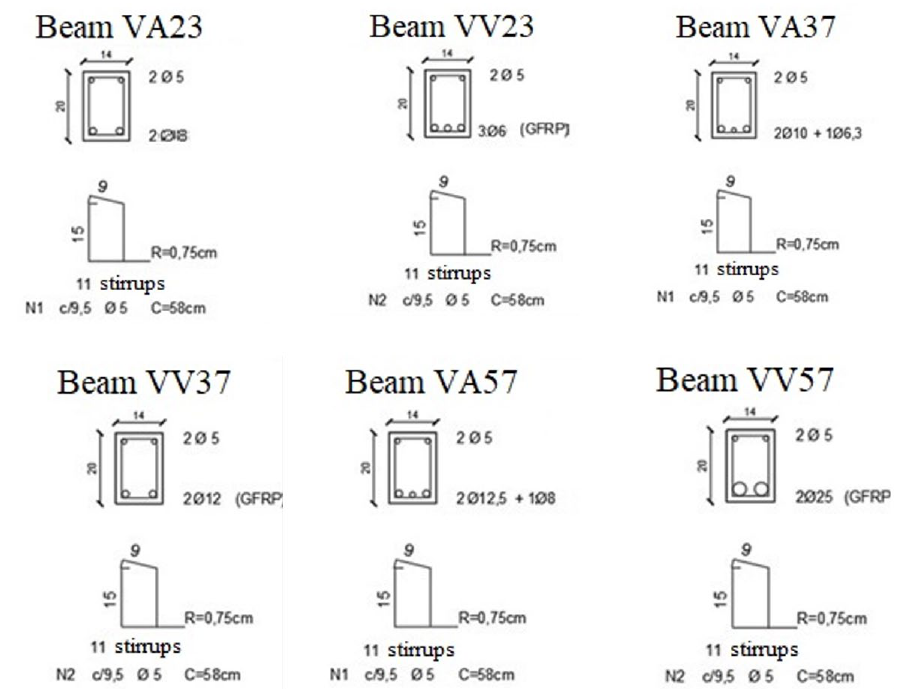
Figure 3. Transversal detailing of the tested beams.